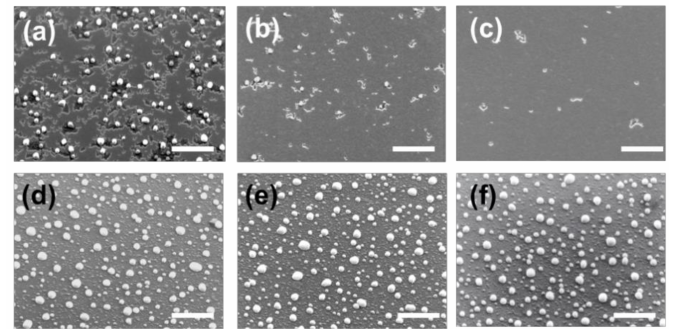
Figure 2. Upper line ( a – c ): SEM images taken in di ff erent spots of sample S2 (low annealing temperature T = 580 ◦ C). Lower line ( d – f ): SEM images taken in di ff erent spots of sample S5 (high annealing temperature T = 750 ◦ C). The white bar corresponds to 1 µ m